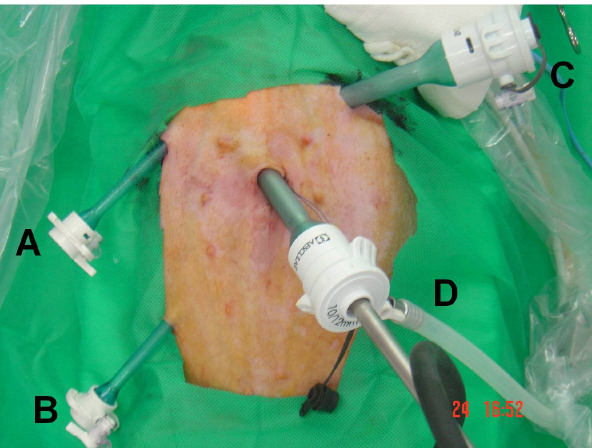
FIGURE 1 - Sites of placement of trocars in the abdomen of pigs subjected to procedure of the common bile duct ligation by laparoscopy. A - flow area to the right costal margin; B - level of the right iliac fossa; C - caudal to the left costal margin; D - pre-umbilical